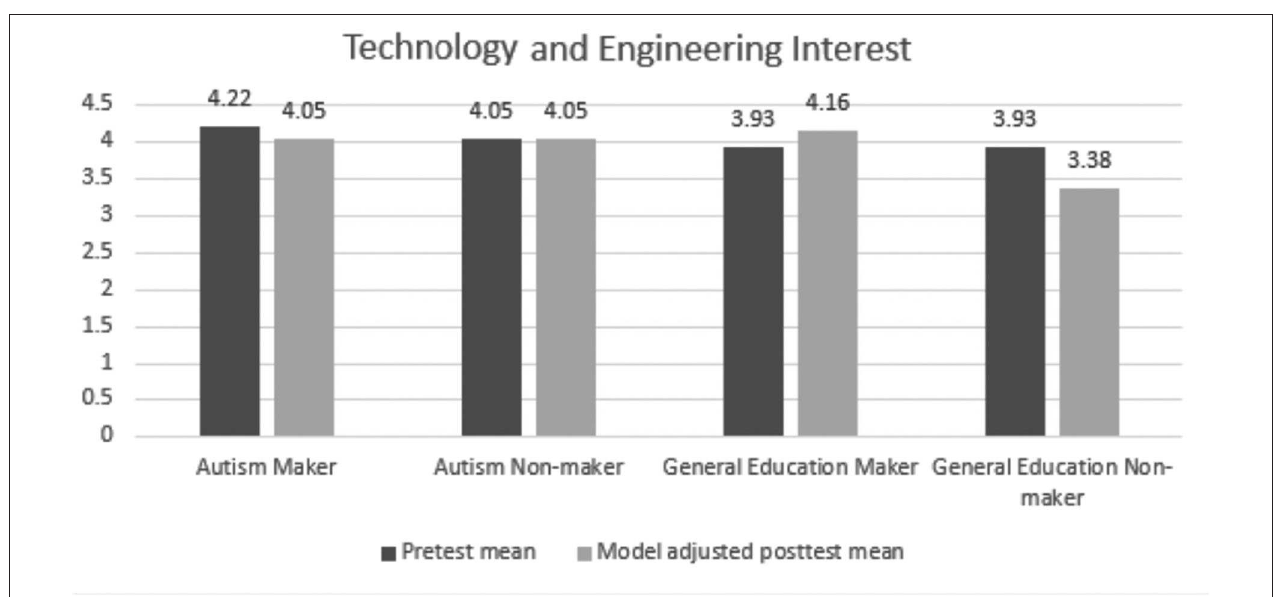
FIGURE 3 | Estimated means for the Technology and Engineering Career Interest